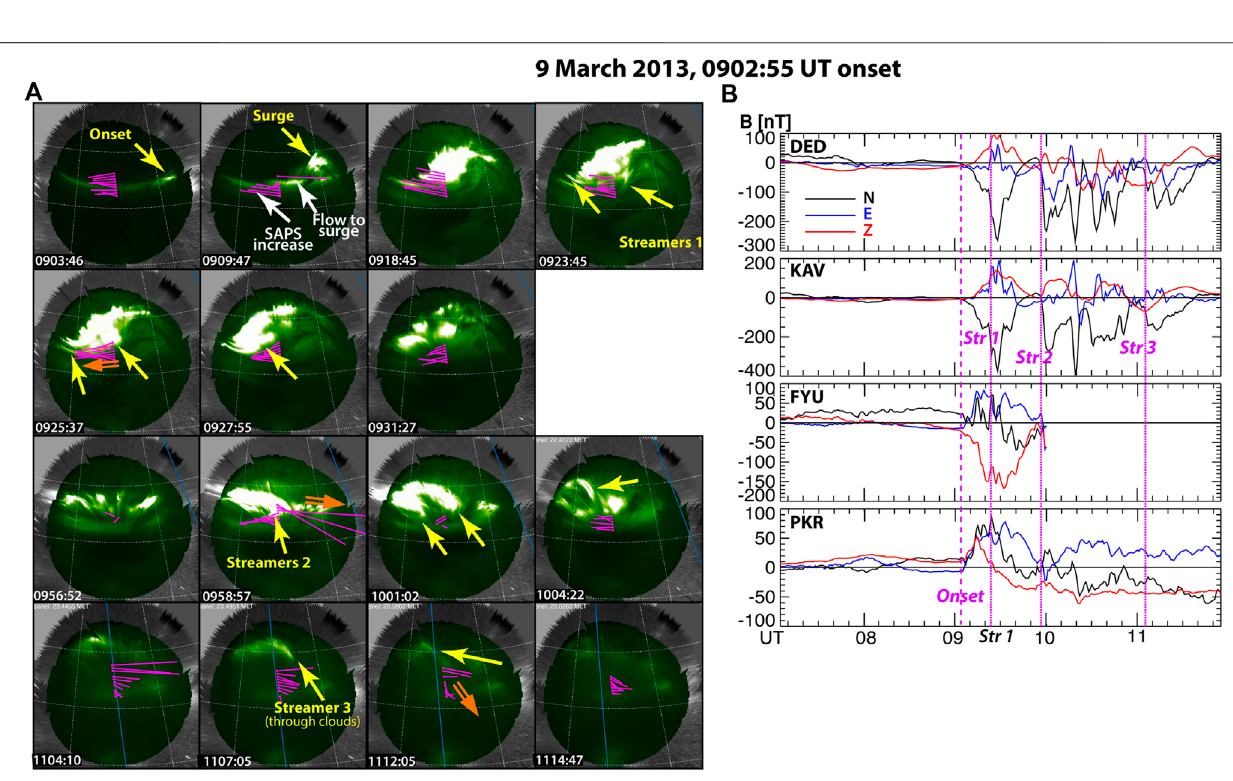
Frontiers in Astronomy and Space Sciences |